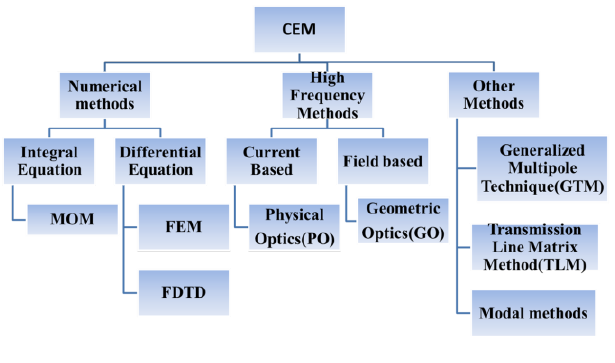
Figure 1: Computational